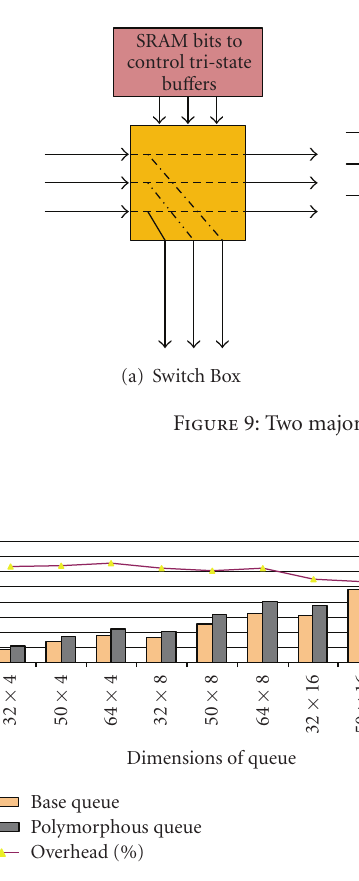
Figure 10: Area overhead of modified queues over base queues.